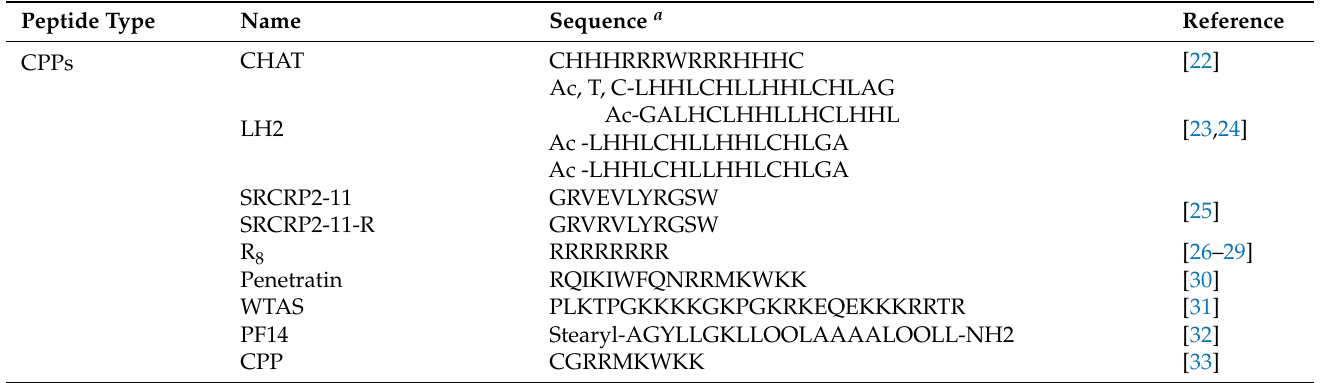
Table 1. Types of peptides designed for use in gene delivery.